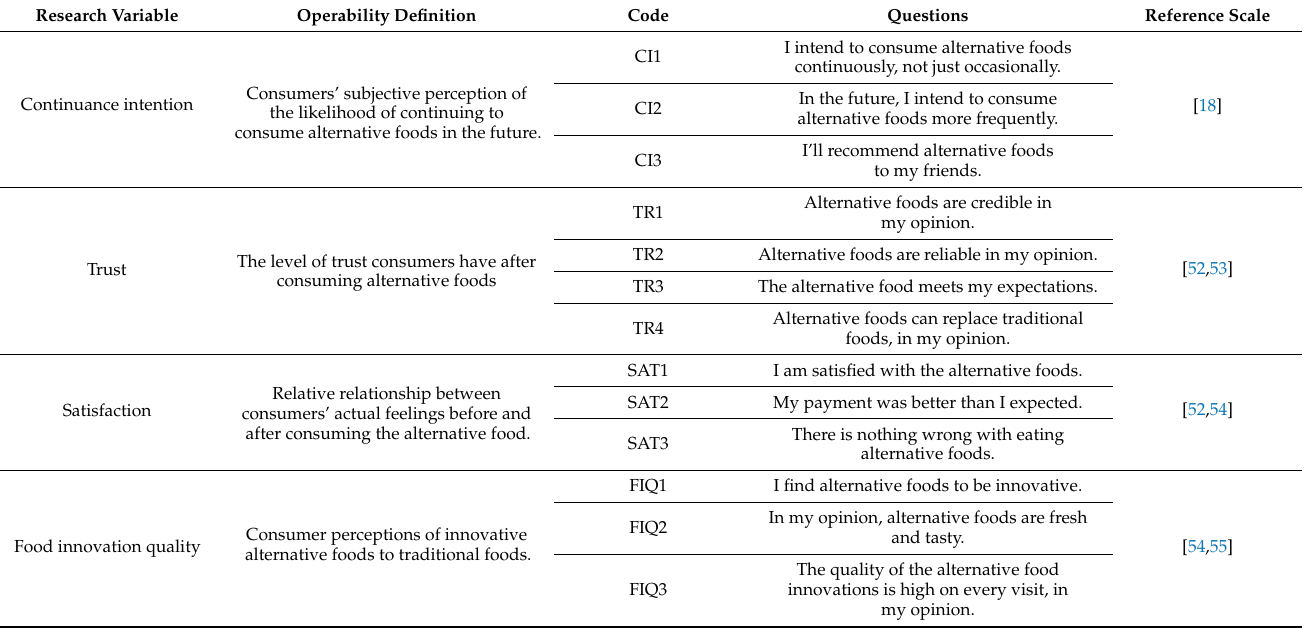
Table 1. Definitions of variable operability and reference scales.